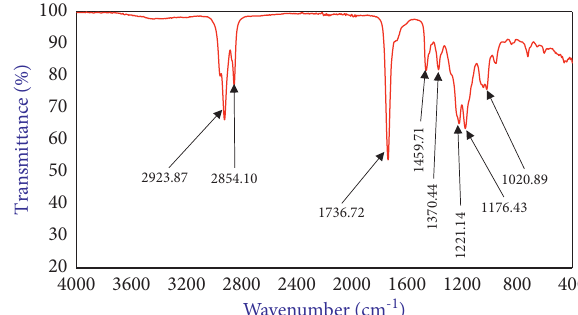
Figure 10: FTIR spectrum of fraction D from the methanol extract of V. camporum